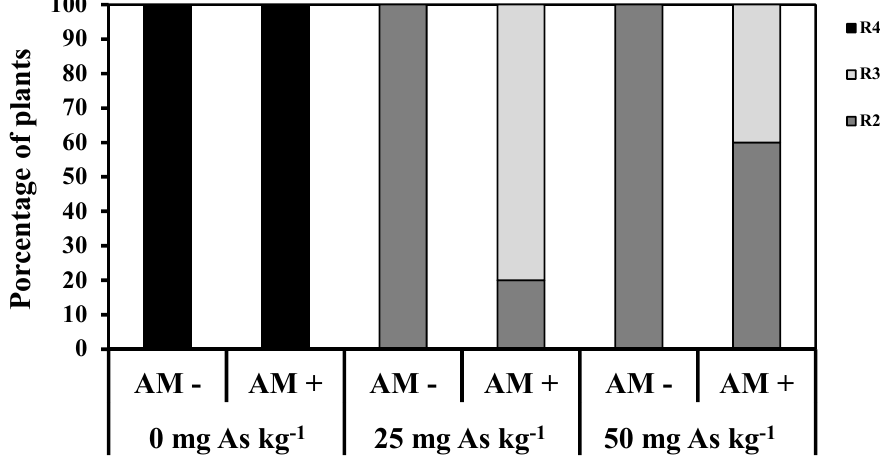
Figure 5. Percentage of soybean plants in different phenological stages, according to the